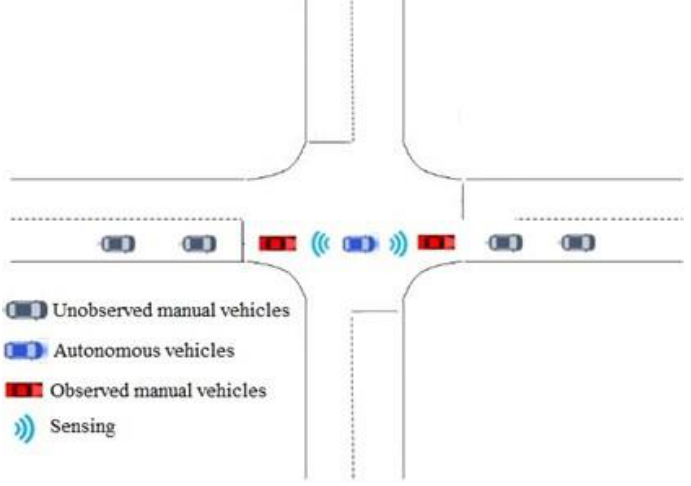
Figure 3. A typical observation.